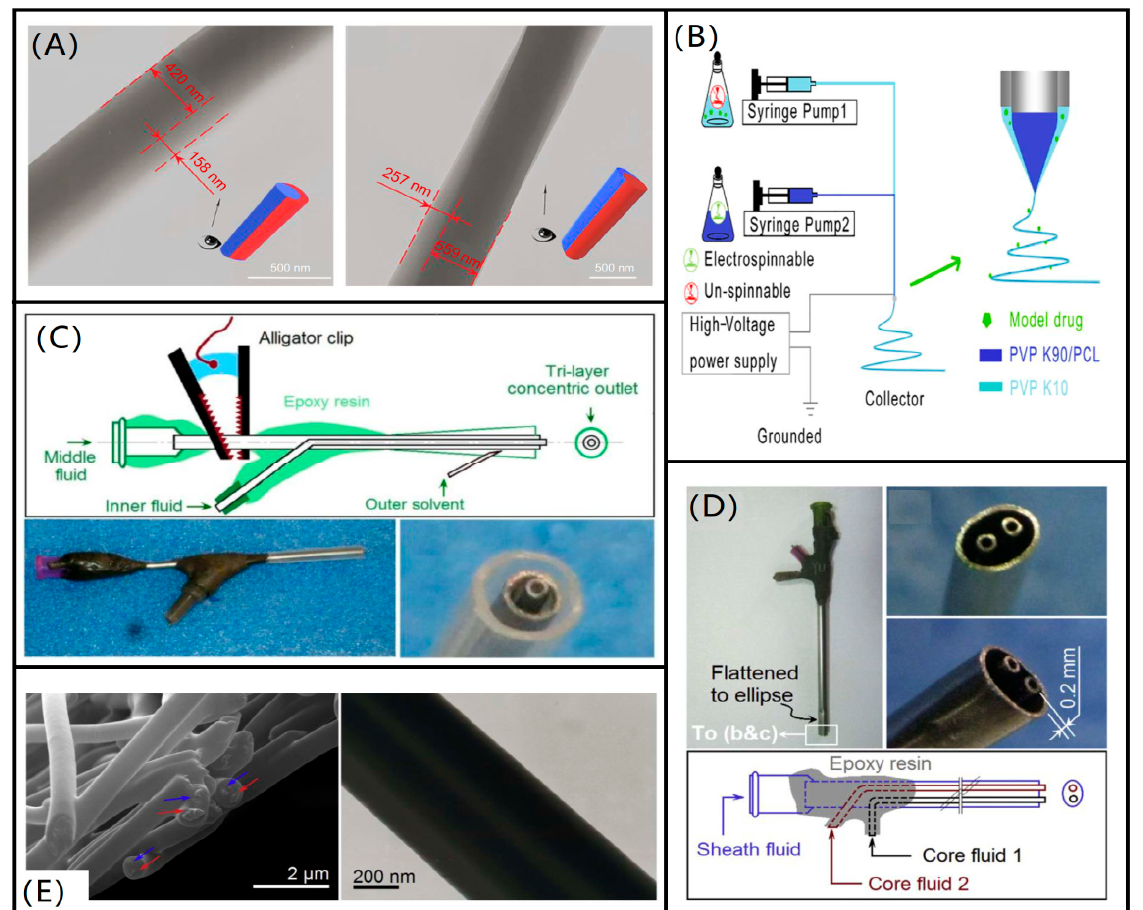
Figure 5. Nanofibers and spinnerets with different structures. ( A ) SEM pictures of nanofibers with Janus structure [66]; ( B ) production process diagram of coaxial electrospinning [73]; ( C ) schematic diagram of three-layer coaxial electrospinning spinneret [77]; ( D ) new three-fluid electrospinning spinneret [78]; ( E ) SEM images of nanofibers with sheath-separate-core nano-structure, as indicated by the red (The PEL-PAR core) and blue arrows (The ES-PAR core)